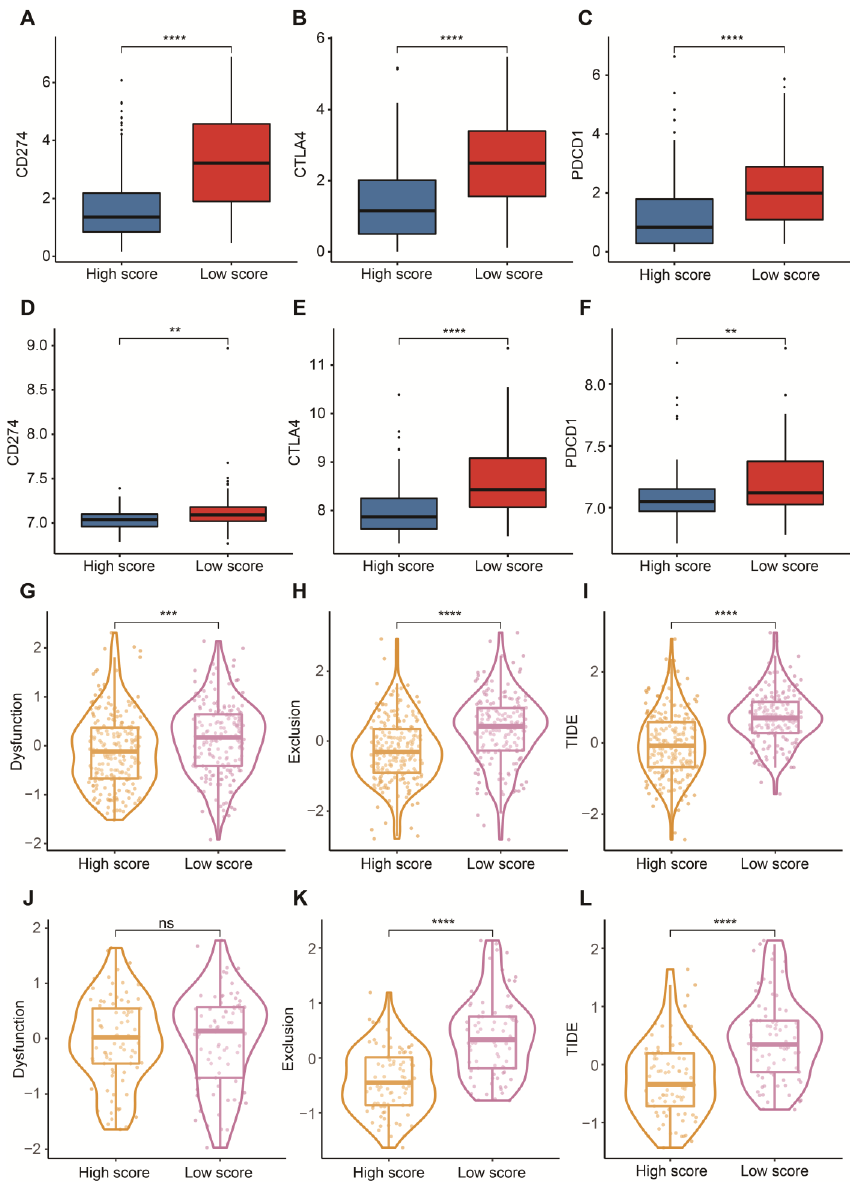
Figure 7. Prediction of immunotherapy. ( A ) Box plots of CD274 between high- and low-score groups in the TCGA-BLCA dataset. ( B ) Box plots of CTLA4 between high- and low-score groups in the TCGA-BLCA dataset. ( C ) Box plots of PDCD1 between high- and low-score groups in the TCGA-BLCA dataset. ( D ) Box plots of CD274 between high- and low-score groups in the GSE13507 dataset. ( E ) Box plots of CTLA4 between high- and low-score groups in the GSE13507 dataset. ( F ) Box plots of PDCD1 between high- and low-score groups in the GSE13507 dataset. ( G ) Distribution of dys- function scores between high- and low-score groups in the TCGA-BLCA dataset. ( H ) Distribution of exclusion scores between high- and low-score groups in the TCGA-BLCA dataset. ( I ) Distribution of TIDE scores between high- and low-score groups in the TCGA-BLCA dataset. ( J ) Distribution of dysfunction scores between high- and low-score groups in the GSE13507 dataset. ( K ) Distribution